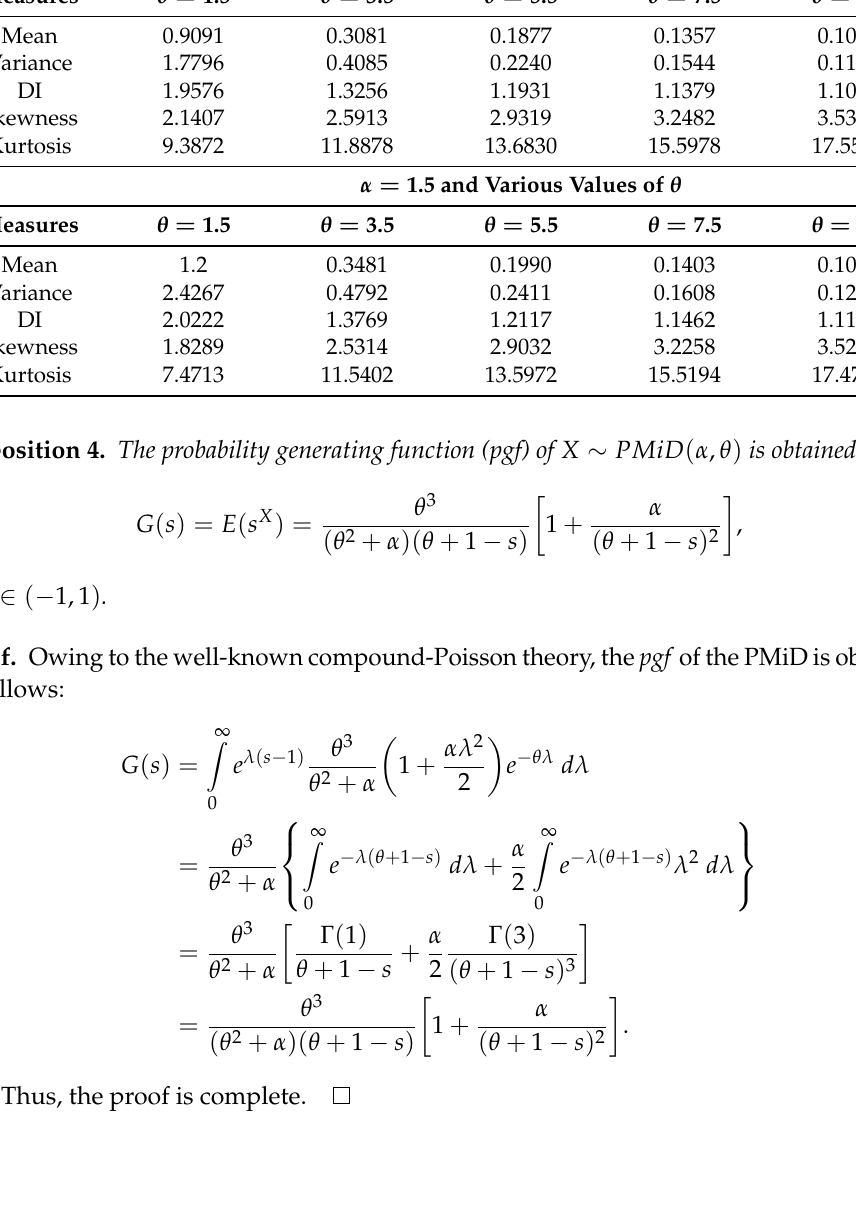
Table 1. Values of some moment measures of the PMiD for various values of α and θ . α = 0.5 and Various Values of θ Measures θ = 1.5 θ = 3.5 θ = 5.5 θ = 7.5 θ = 9.5 Mean 0.9091